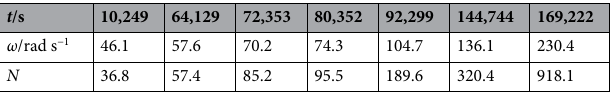
Table 2. Sequences of centrifuge speeds of Run 1 in Case 4 15 .